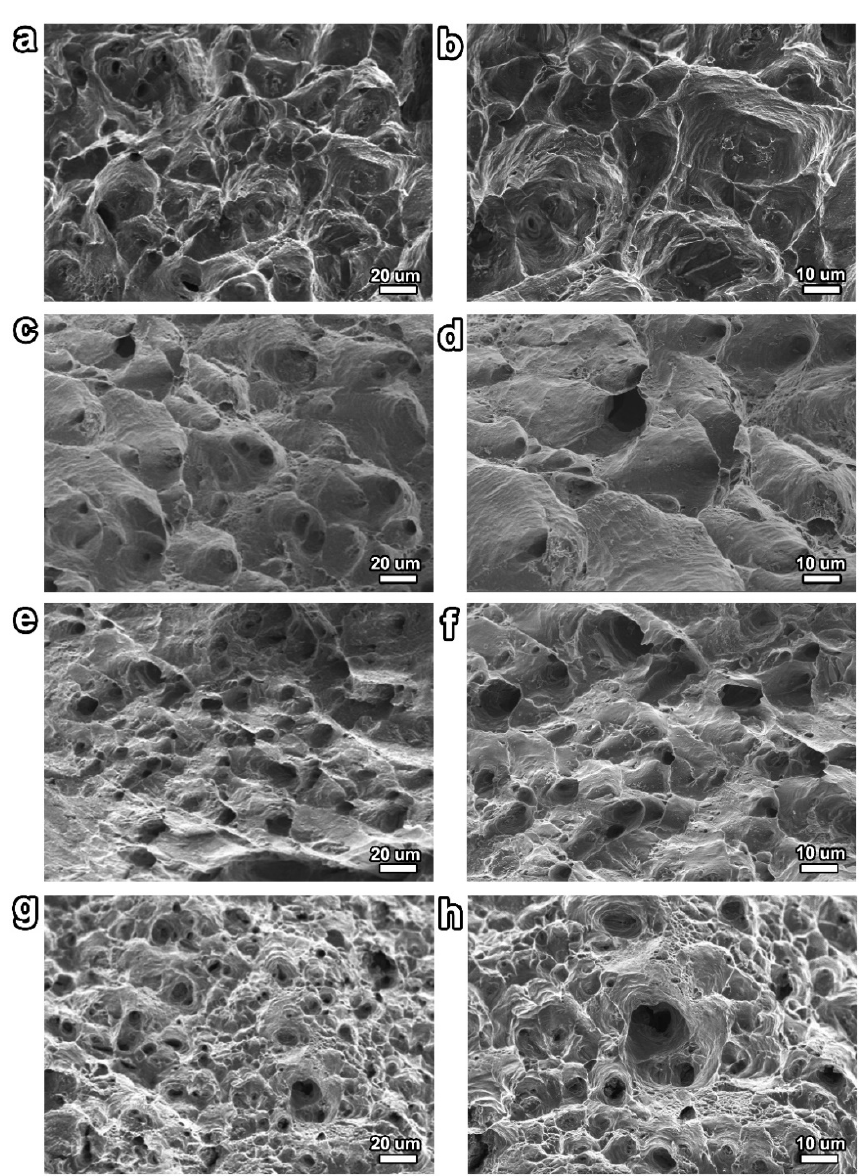
Figure 6. Fractographic SEM images of the initial samples ( a ) and deformed sample at area reduction ratio of 19% ( c ), 58% ( e ) and 91% ( g ), and their corresponding enlarged drawings ( b , d , f , h ).